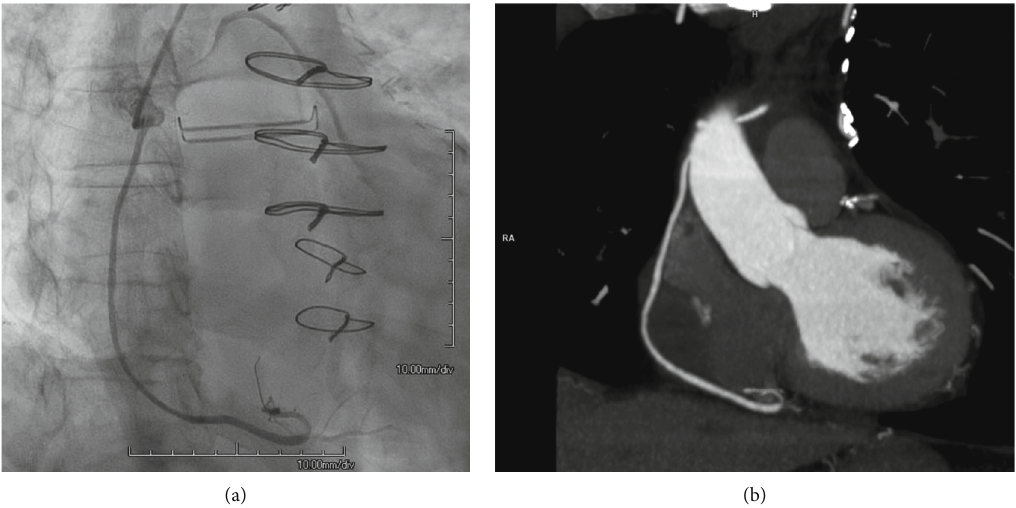
Figure 2: Spontaneous closure of pseudoaneurysm. (a) During left heart catheterization approximately four weeks after initial presentation, there was no detectable pseudoaneurysm, consistent with spontaneous closure. (b) On follow-up CT imaging approximately three and a half months after initial presentation, there was again no detectable pseudoaneurysm and the mediastinal hematoma had decreased in